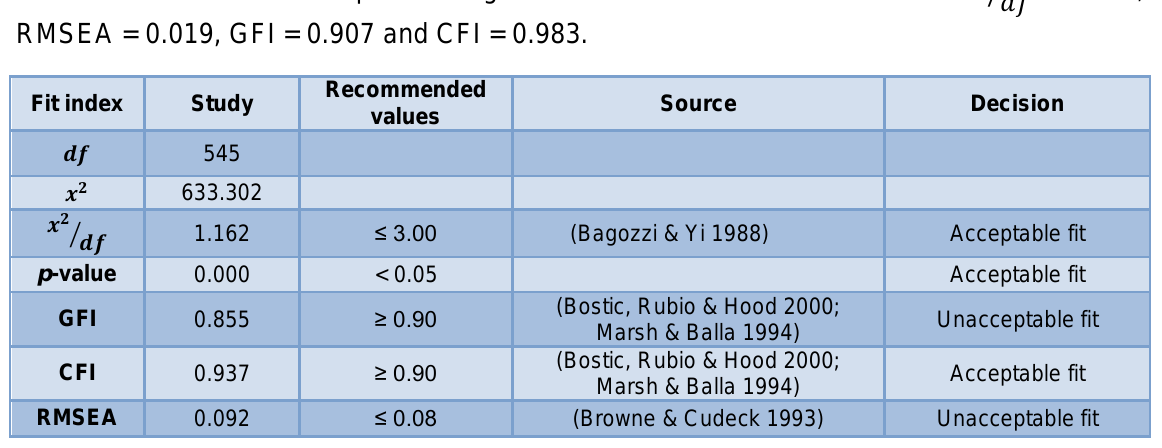
Table 2 Fit indices for the initial structural measurement model